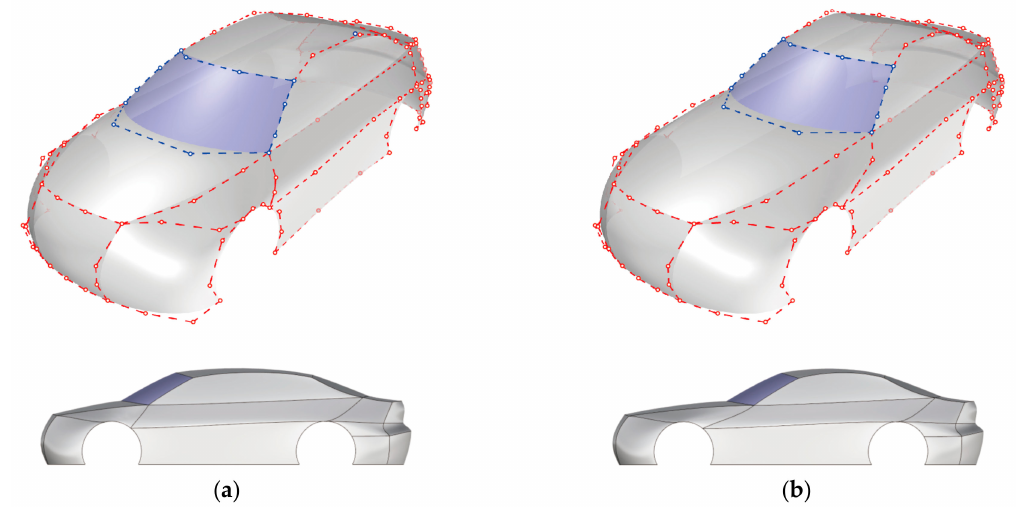
Figure 6. E ff ect of altering the control point on vehicle modeling: ( a ) Moving the control points of the windshield forward; ( b ) Moving the control points back.